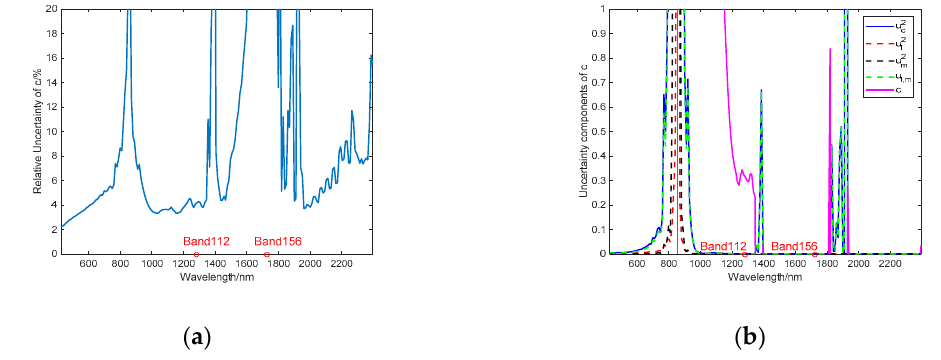
Figure 7. Absolute uncertainty and relative uncertainty of parameter c . ( a ) Relative uncertainty; ( b ) absolute uncertainty and its components. In subplot ( b ), the blue solid line is the combined variance of c ; the dashed lines are the uncertainty components associated with intercept l (red), slope m (black), and the correlation component between l and m (green); the pink solid line is the value of c .